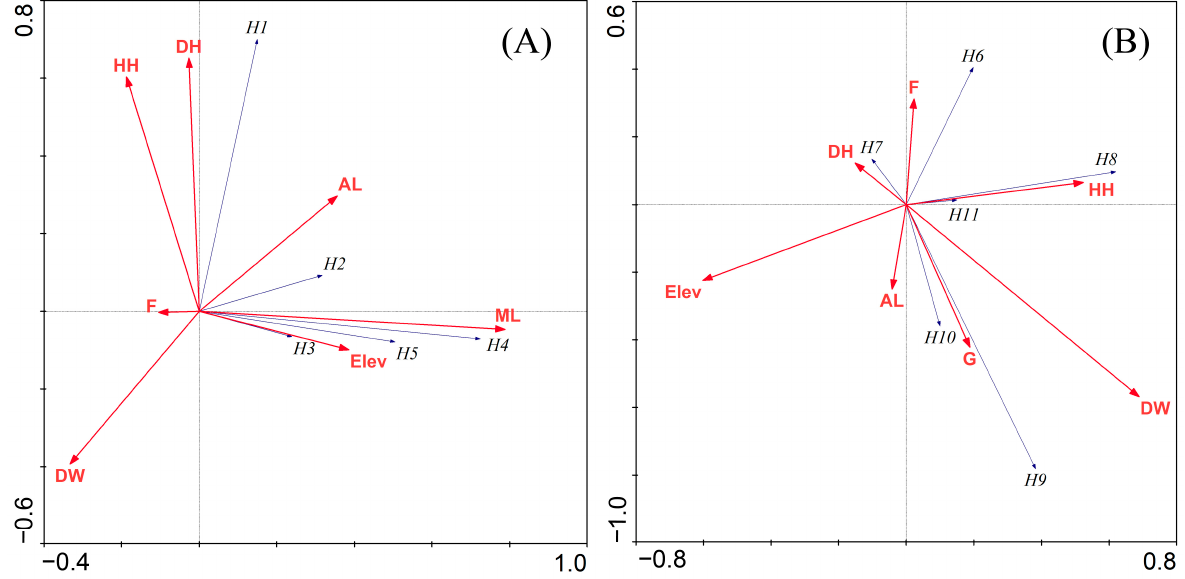
Figure 5. RDA ordination diagram (biplot) showing the association of environmental variables with the herpetofauna in the RWC; ( A ) Amphibians; and, ( B ) Reptiles. Note: F = Forest, ML = Marsh Land, AL = Agricultural Land, G = Grassland, HH = Human Habitat, DW = Nearest distance to water resource, Elev = Elevation, DH = Nearest distance to human settlement.